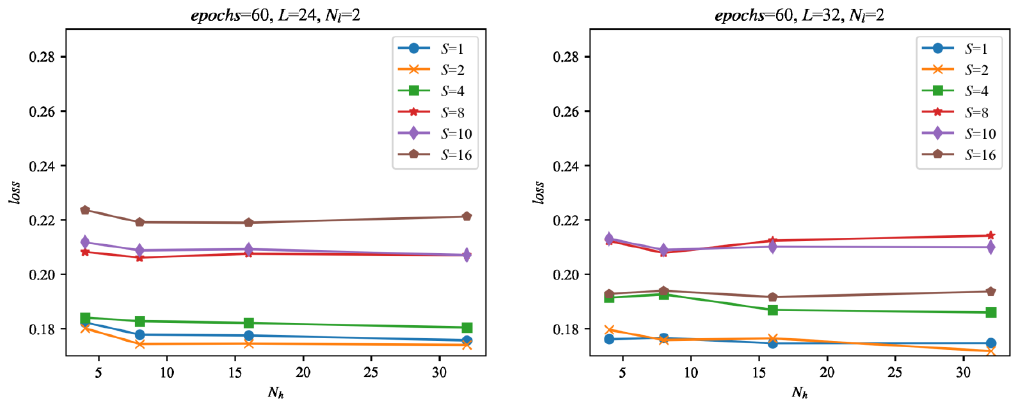
Figure 11. Evaluation of the networks during training as a function of the number of neurons in the hidden layer(s) N h . The evaluation was made using the set of 29 evaluation signals, not used for training, for all of the configurations of the networks considered in this paper. The loss is calculated as an average evaluation loss of all evaluation signals. For the loss values on the vertical axes in the graphs, the best evaluation loss found after the given number of epochs was used.